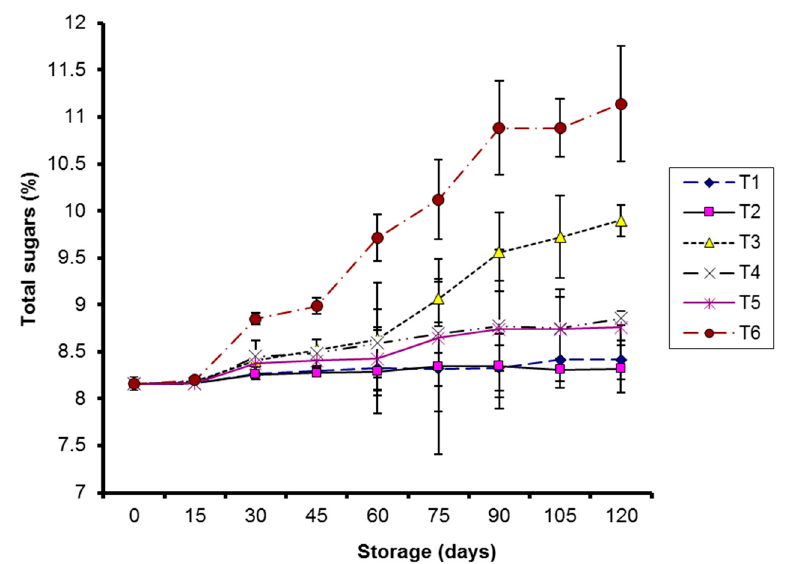
Figure 5. Effect of CMC and guargum-based silver nanoparticle coatings on the total sugars of kinnow fruit stored at 4 and 10 °C during storage. The vertical bars represent standard error of the means. Values represented as mean ± SE of three replicates.